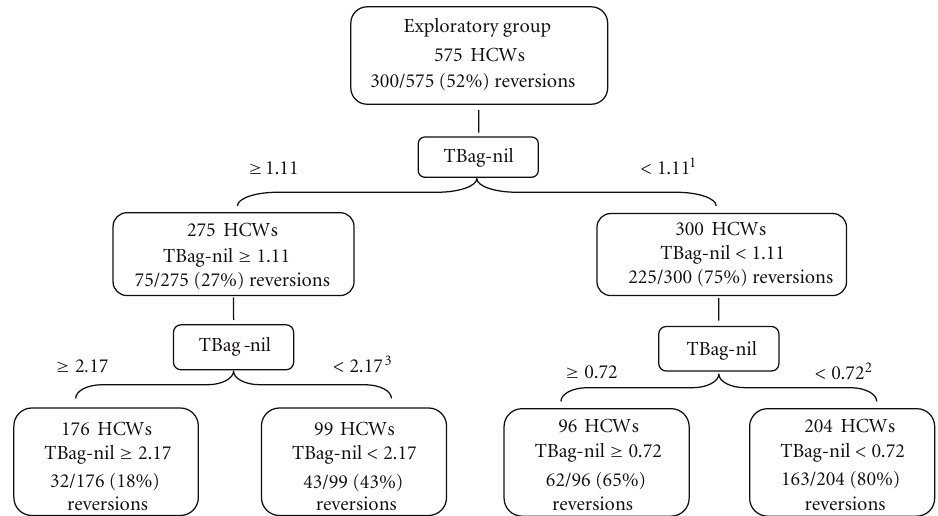
Figure 1: Receiver operating characteristic (ROC) decision tree identifying statistically significant TBag-nil (in IU/mL) separation points which predict those HCWs with a positive TB test result at time one who retest negative at time two. Logistic regression analysis on a separate Confirmatory sample of 287 HCWs validated all 3 separation points at 0.72, 1.11, and 2.17 IU/mL and remained statistically significant for all subgroups by chi-square ( P < 0 . 001). 1 Kappa = 0 . 48, chi-square = 131 . 0, P < 0 . 001, 2 Kappa = 0 . 16, chi-square = 8 . 2, P < 0 . 01, 3 Kappa = 0 . 27, chi-square = 20 . 4, P < 0 . 001.